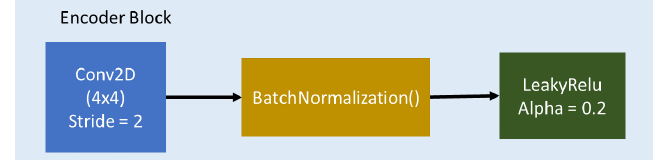
Figure 5. Encoder block.